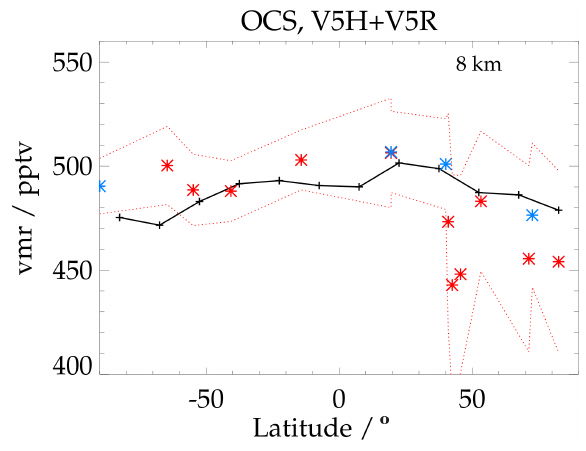
Figure 8. Latitudinal variation of MIPAS OCS data at 8km altitude, averaged over the whole measurement period from 2002 to 2012 (black curve), and OCS amounts (flask data) from NOAA ESRL surface stations (stars), averaged over the same time period. Sur- face stations indicated by red stars are situated at low altitudes in the boundary layer and surface stations indicated by blue stars on mountains in the free troposphere. The red dotted curves represent the 1 σ standard deviation of the flask